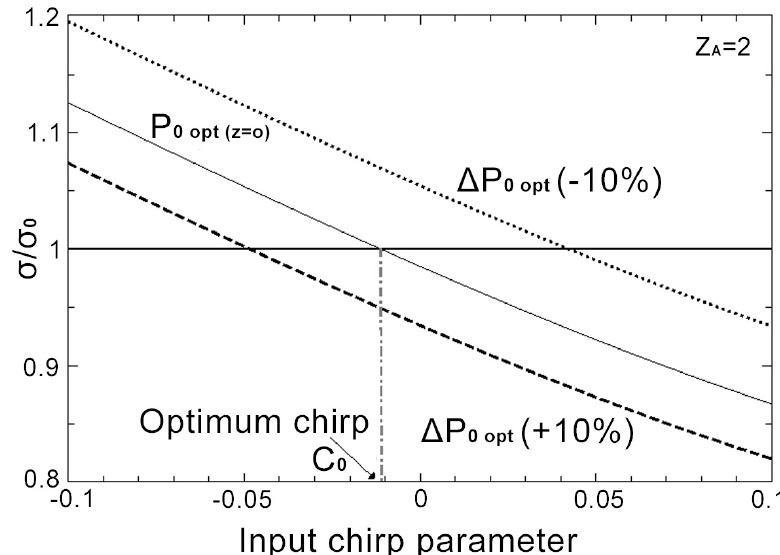
Figure 6. Change in the widening factor through an amplification stage for the vectorial soliton with z A = 2.0 vs. the initial chirp, for different peak powers in z = 0. We assume a PMD value of D p = 0.5 ps · km − 1/2 .